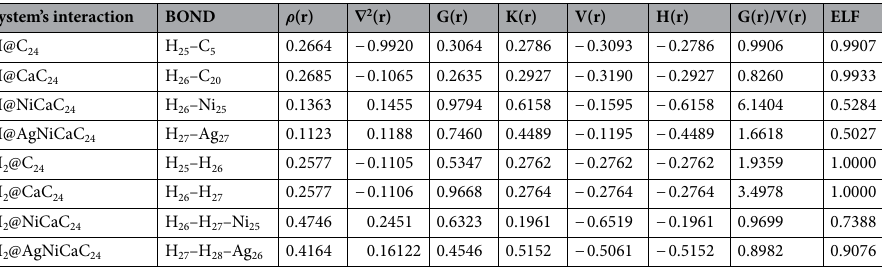
Table 2. The obtained values of the topological parameters of the BCP’s of the studied hydrogenated systems from QTAIM analyses.